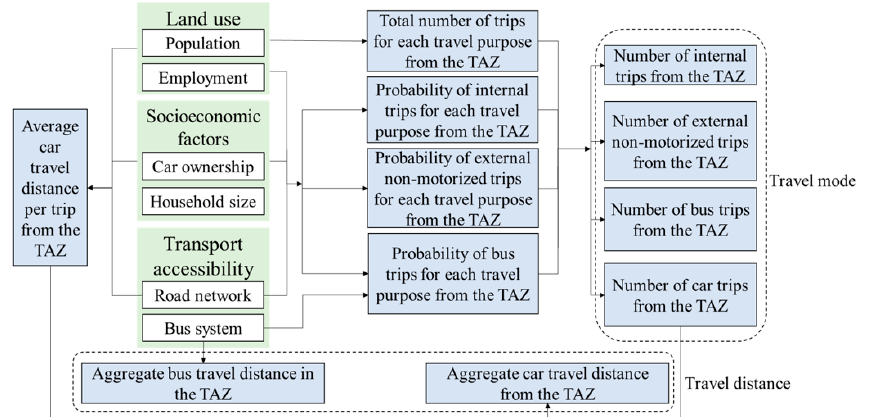
Figure 4. Framework of the mixed-use development model.